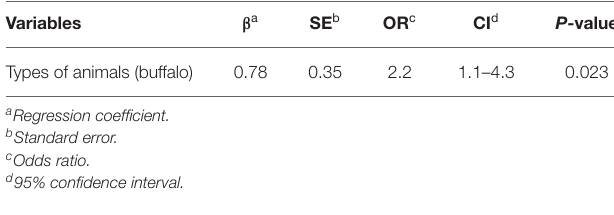
TABLE 4 | Final multiple logistic regression models to find factors affecting bovine tuberculosis (bTB) in animals at the Chiang Mai Municipal abattoir, Thailand.